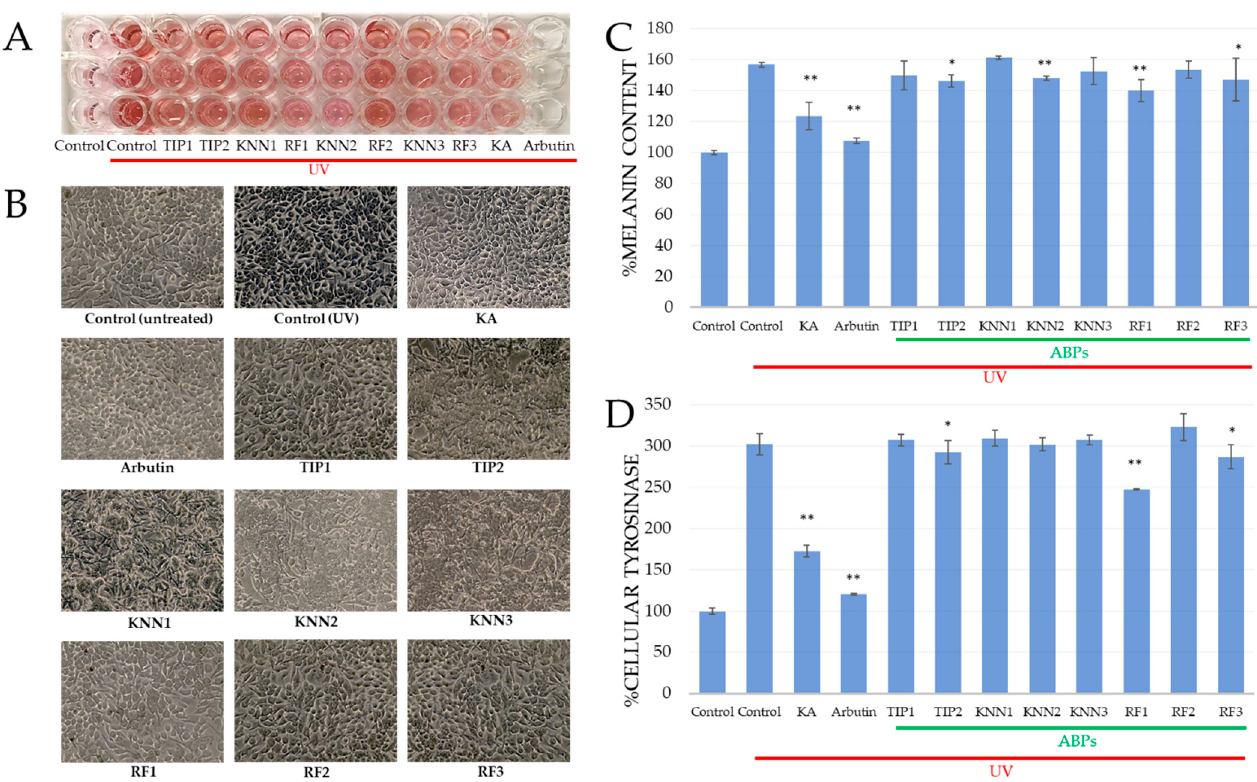
Figure 3. Effects of hdTIPs on melanin content ( A – C ) and ( D ) cellular tyrosinase activity of B16F10 melanoma cells. ( A ) Photography of cultured cell with medium in 96-well microplate and ( B ) morphological observation of B16F10 cells treated with hdTIPs. The data were normalized by setting 100% equal to the non-UV-induced of the untreated control group. The significant differences were indicated at p < 0.01 (**) and p < 0.05 (*) . Error bars represented standard error of the mean.